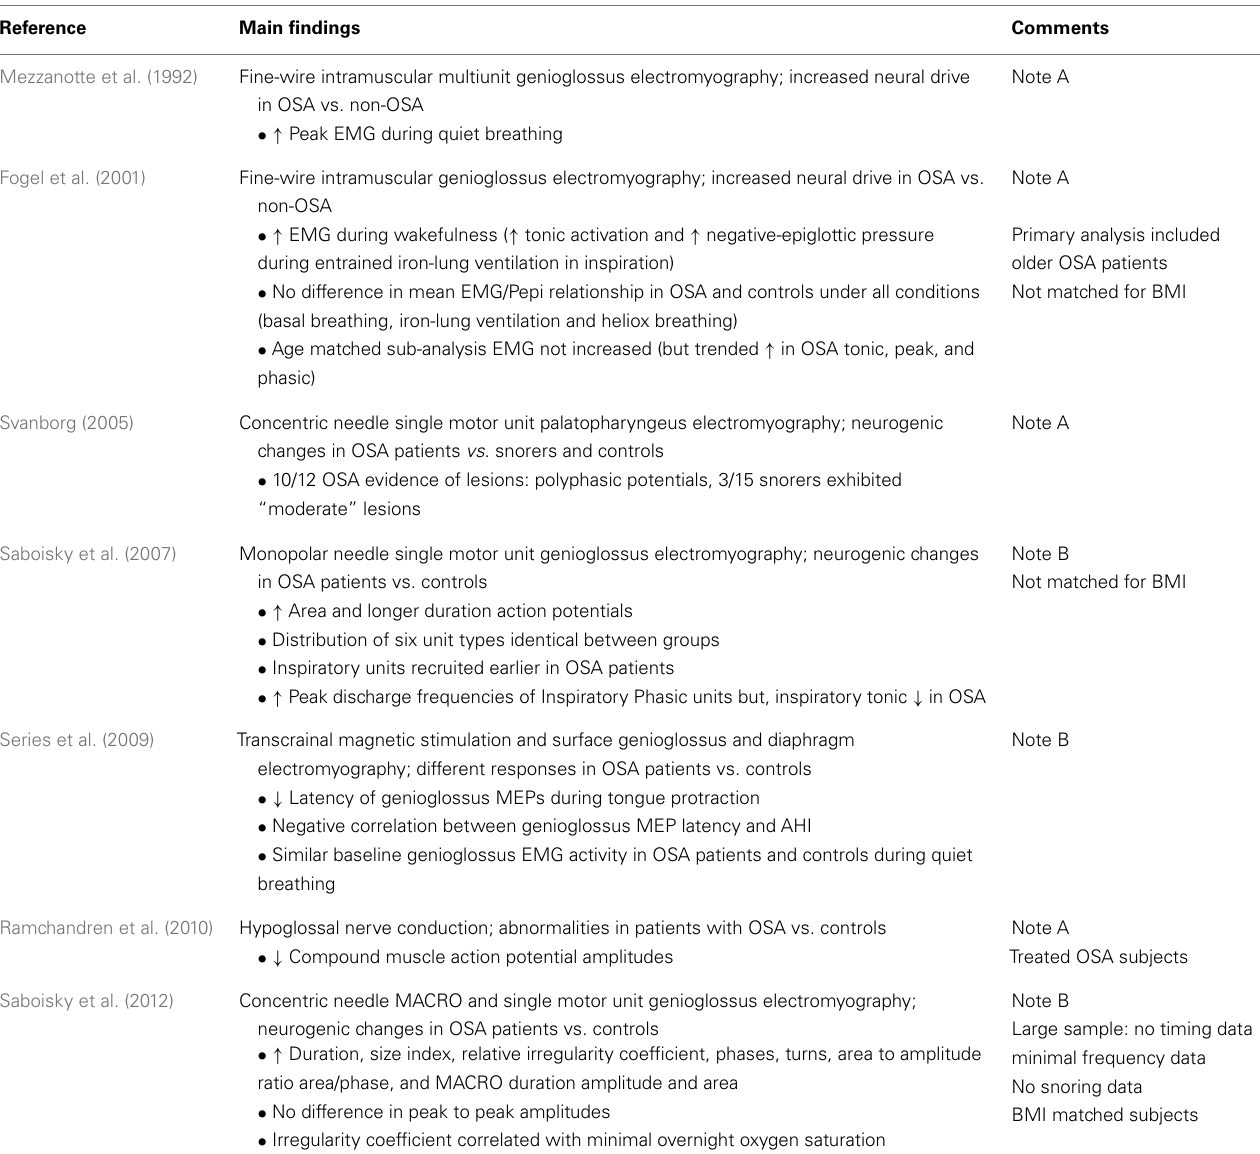
Table 3 | Efferent